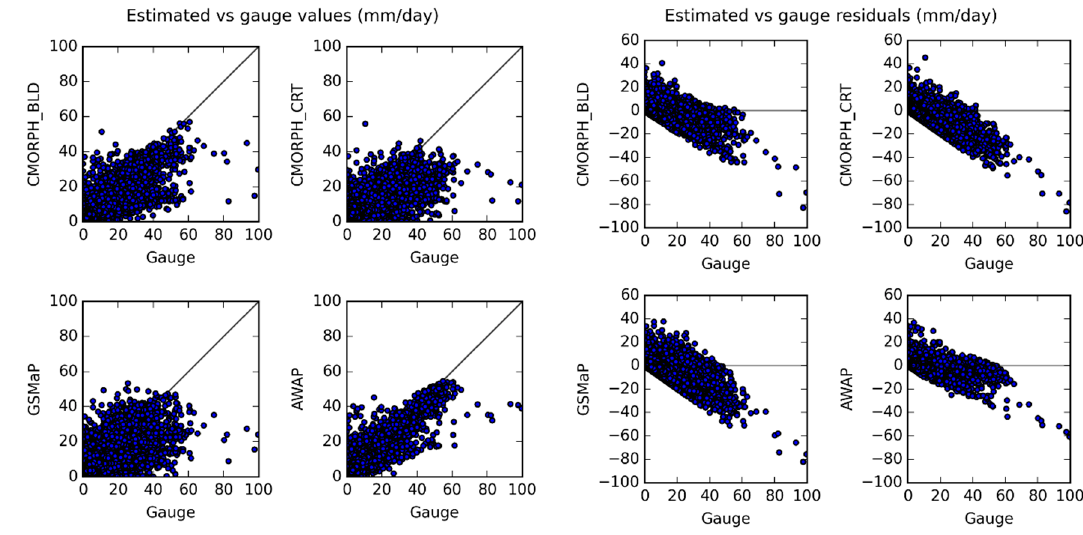
Figure 5. Scatterplot comparisons of satellite datasets against point gauge data from January 2001 to December 2018.